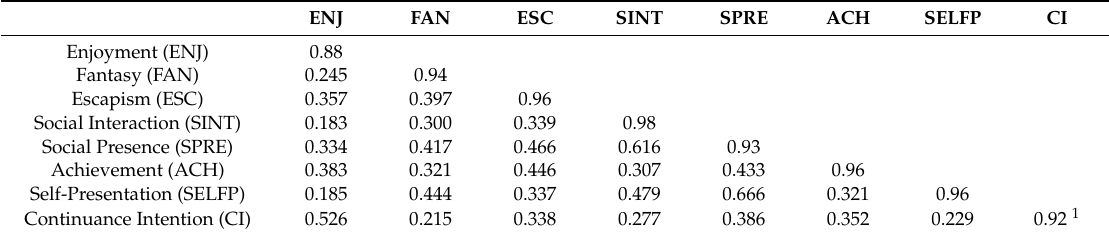
Table 3. Discriminant